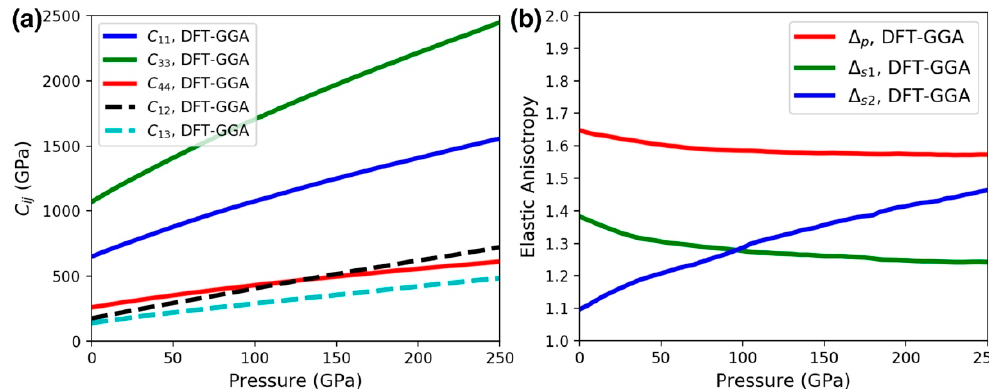
Figure 9. ( a ) The five independent elastic constants computed by density functional theory (DFT) with the generalized gradient approximation (GGA) functional for hexagonal ReB 2 as a function of pressure. ( b ) Parameters indicative of elastic anisotropy for a hexagonal crystal: ∆ p = c 33 / c 11 , ∆ s1 = (c 11 + c 33 − 2c 13 ) / 4c 44 , and ∆ s2 = 2c 44 / (c 11 − c 12 ) . For isotropic compressibility, all parameters are equal to unity.